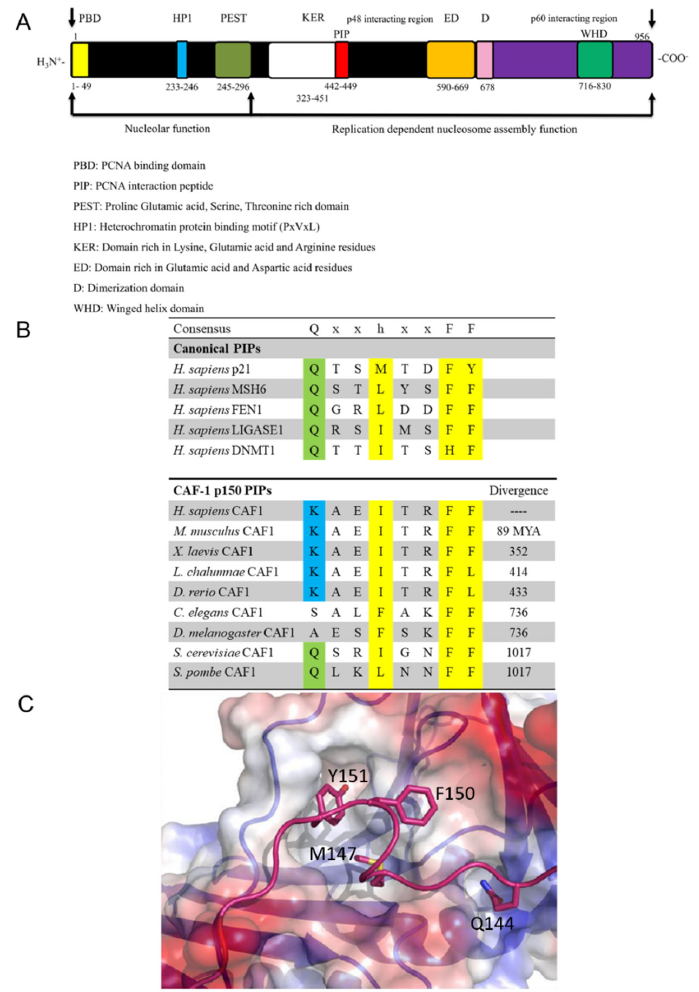
Figure 1. Differences between canonical PIPs and the non-canonical PIP in the p150 subunit of CAF-1. ( A ) Domains of the human CAF-1 p150 subunit ( B ) Amino acid alignment of canonical PIPs versus evolutionarily conserved CAF-1 p150 PIPs. The evolutionary divergence is shown in the extreme right column (million years ago = MYA) ( C ) Plug and socket binding mode in the structure of the canonical p21 PIP bound to PCNA [19]. The p21 PIP is shown in pink. PCNA hydrophobic surfaces are depicted in white, whereas positively and negatively charged surfaces are respectively in blue and red. Residues of the canonical PIP of p21 are shown in stick representation: Q144, M147, F150, and Y151. Q144 occupies the Q pocket of PCNA and M147, F150, and Y151 form the three prongs of the hydrophobic plug that binds to the PCNA